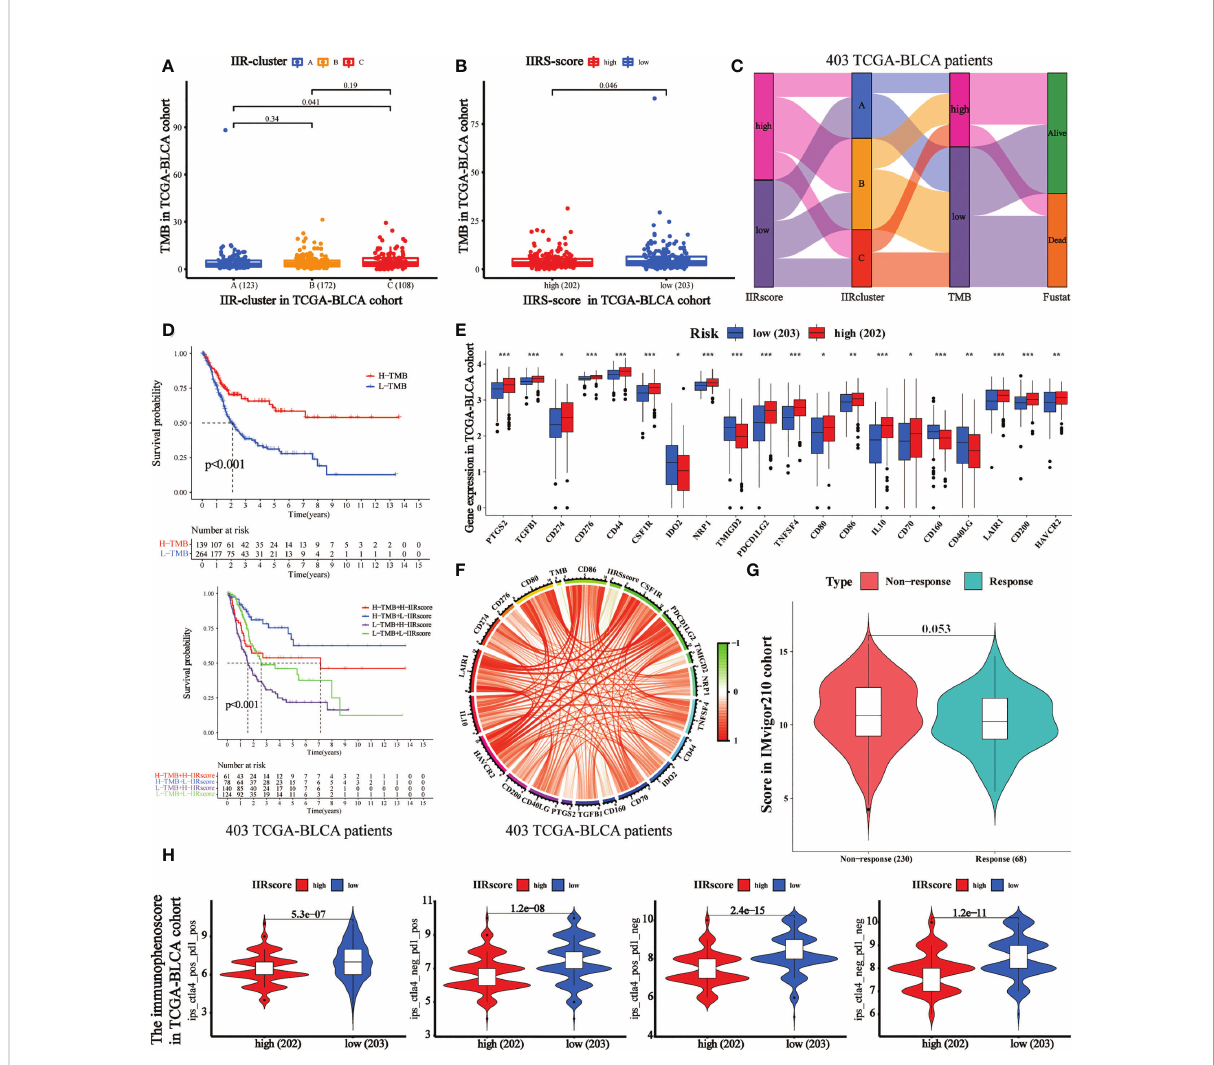
FIGURE 5 Evaluation of the performance of IIRS in the TCGA-BLCA patients ’ immunotherapy. (A) The distribution of the TMB value in different IIR-clusters in TCGA-BLCA patients. (B) Differences in the TMB value between high- and low-risk IIRS groups. (C) The Sankey diagram was used to visualize the relation between IIR-clusters, IIRS-score groups, and TMB. Each column indicates a characteristic variable, different colors show different types, and lines represent the distribution of the same sample in different characteristic variables. (D) KM curves for different groups strati fi ed by TMB or combining IIRS with TMB in the TCGA-BLCA cohort. (E) Differences in the expression of immune checkpoints between high- and low- risk IIRS groups. The upper and lower ends of the boxes refer to an interquartile range of values. (F) The correlation chord chart displays the mutual correlation among IIRS risk score, TMB, and checkpoints. (G) The differences in the clinical response (CR/PR, SD/PD) to anti – PD-1 immunotherapy in high or low IIRS-score groups in the IMvigor210 cohort. (H) The differences of the immunophenoscore (IPS) to anti – PD-1 or/ and anti – CTLA4 immunotherapy in high or low IIRS-score groups. ***P < 0.001; **P < 0.01; *P <